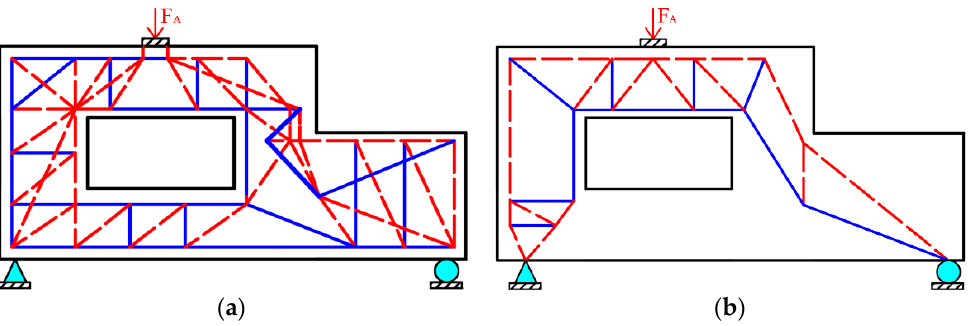
Figure 8. Optimal STMs proposed by Ley et al.: ( a ) STM A-02; ( b ) STM A-03.